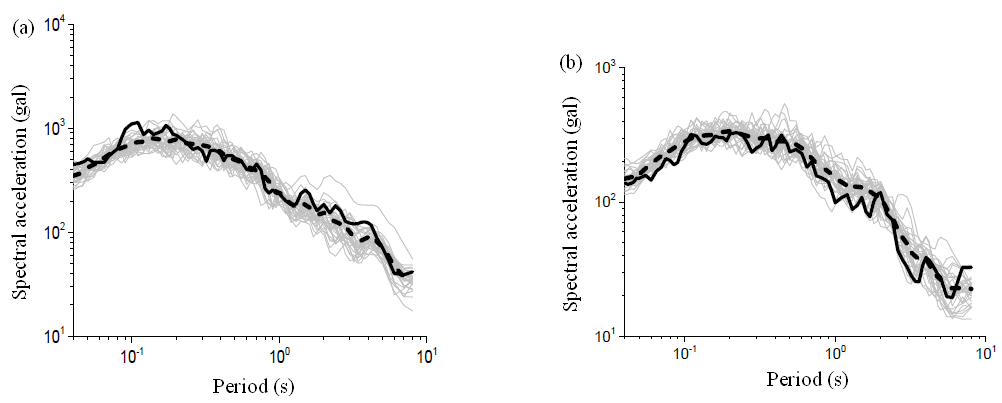
Figure 9. Acceleration response spectra of motions from 30 hybrid source models at (a) Maoxian station (51MXT) and (b) Pixian station (51PXZ), redrawn from Tao et al. (2013).